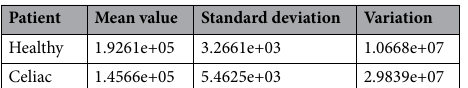
Table 9. Interpretation of the values obtained after applying the Sobel filter.